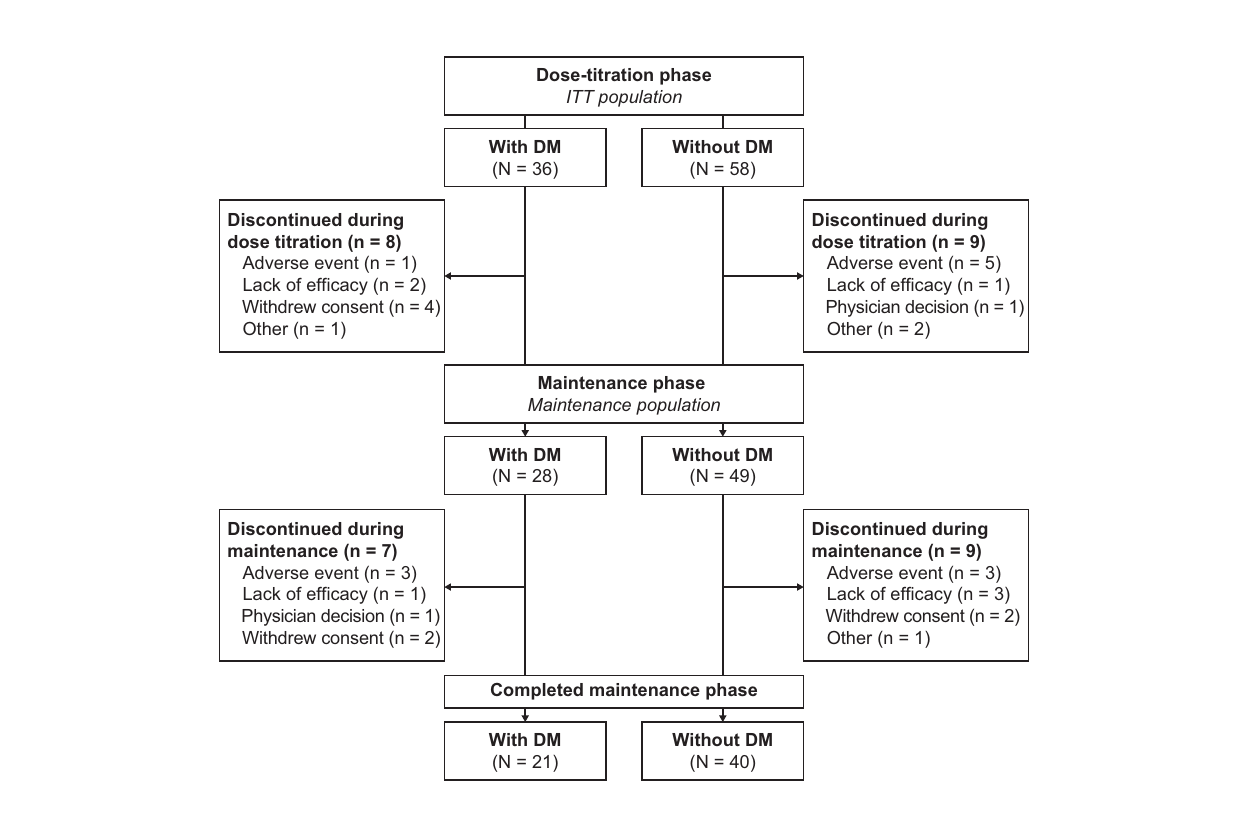
FIGURE 1 | Patient disposition. ITT population included all patients who received ≥ 1 dose of study medication. Maintenance population consisted of all patients who entered the maintenance phase and received ≥ 1 dose of study medication during this phase. DM, diabetes mellitus; ITT, intent-to-treat.